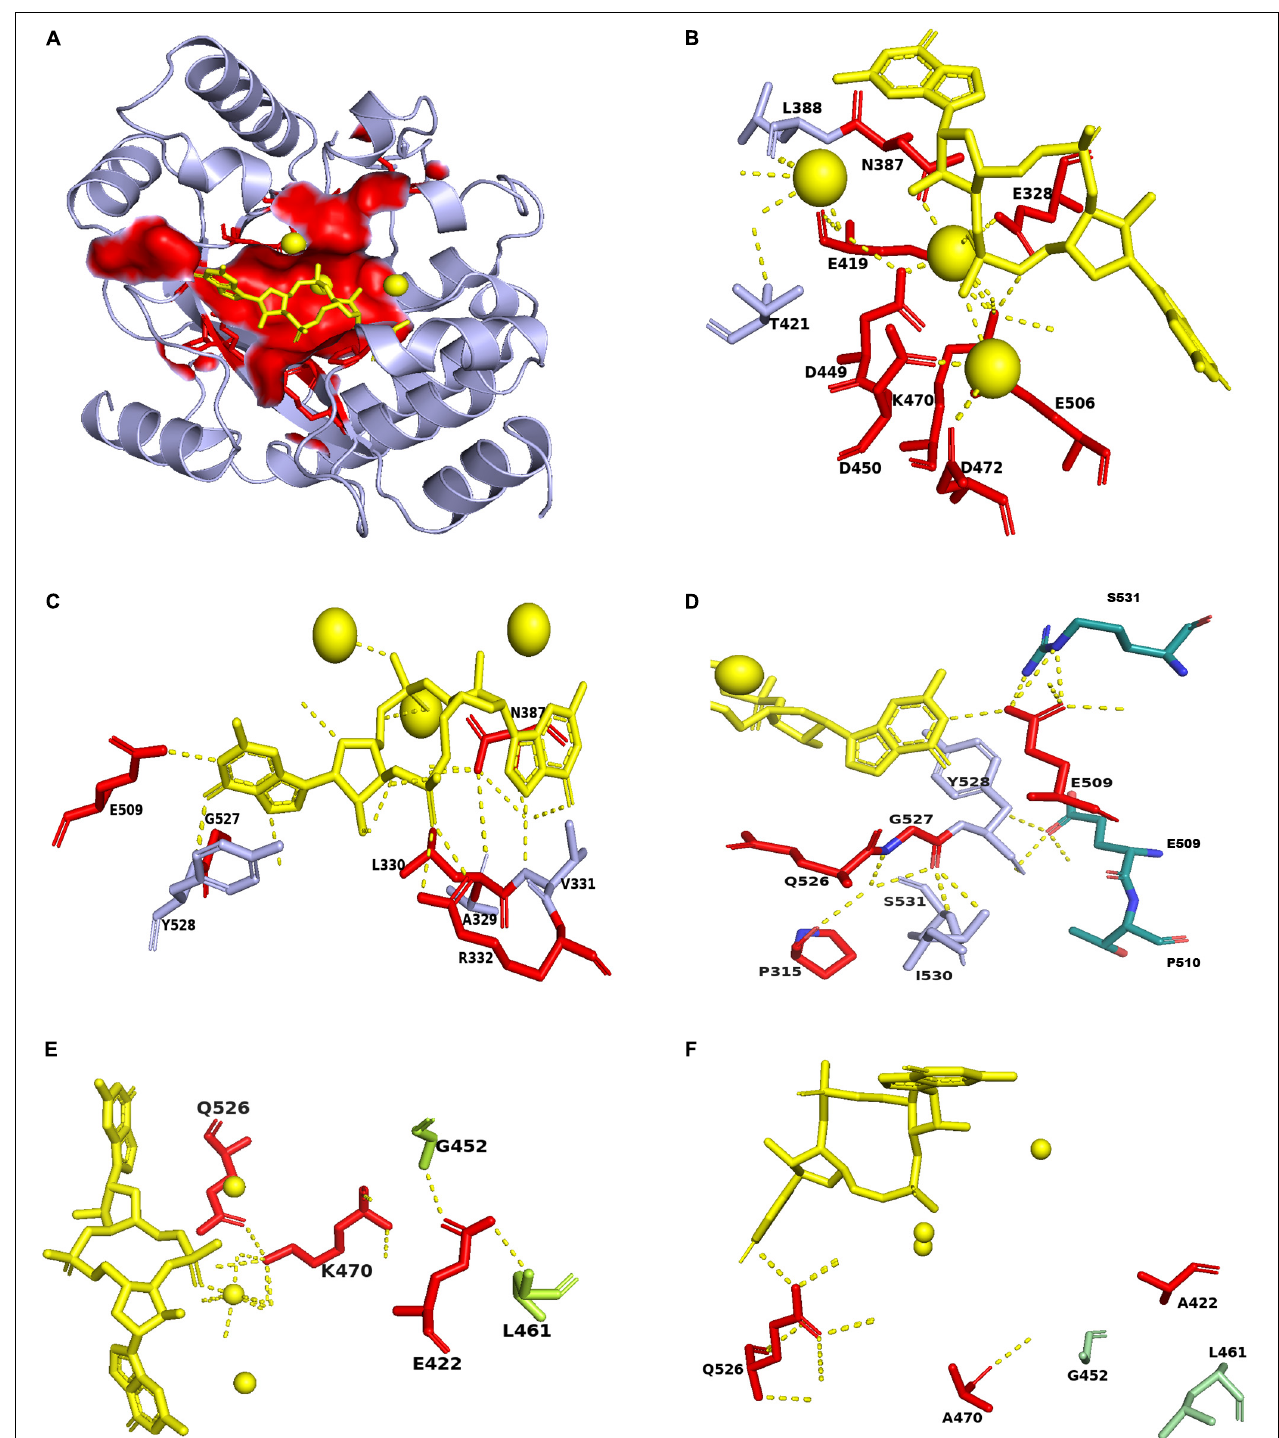
FIGURE 7 | Mapping of conserved residues identified in ProE with homolog model. (A) The surface structure showing the localization of the conserved residues in the ProE model around the calcium ions and c-di-GMP. (B) The labeled residues indicate those interact with the calcium ions in ProE. (C) The labeled residues indicate those form direct or indirect polar contacts with c-di-GMP. (D) The residues E509 and Y528 interact with S531 and E509, respectively, from another monomer to allow dimer formation. (E) Interaction of conserved residues K470 and E422 with their adjacent residues. (F) Interaction of K470A and E422A with their adjacent residues. Calcium ions and c-di-GMP molecules are shown as yellow spheres and sticks, respectively. Polar interaction are shown as yellow dashes.